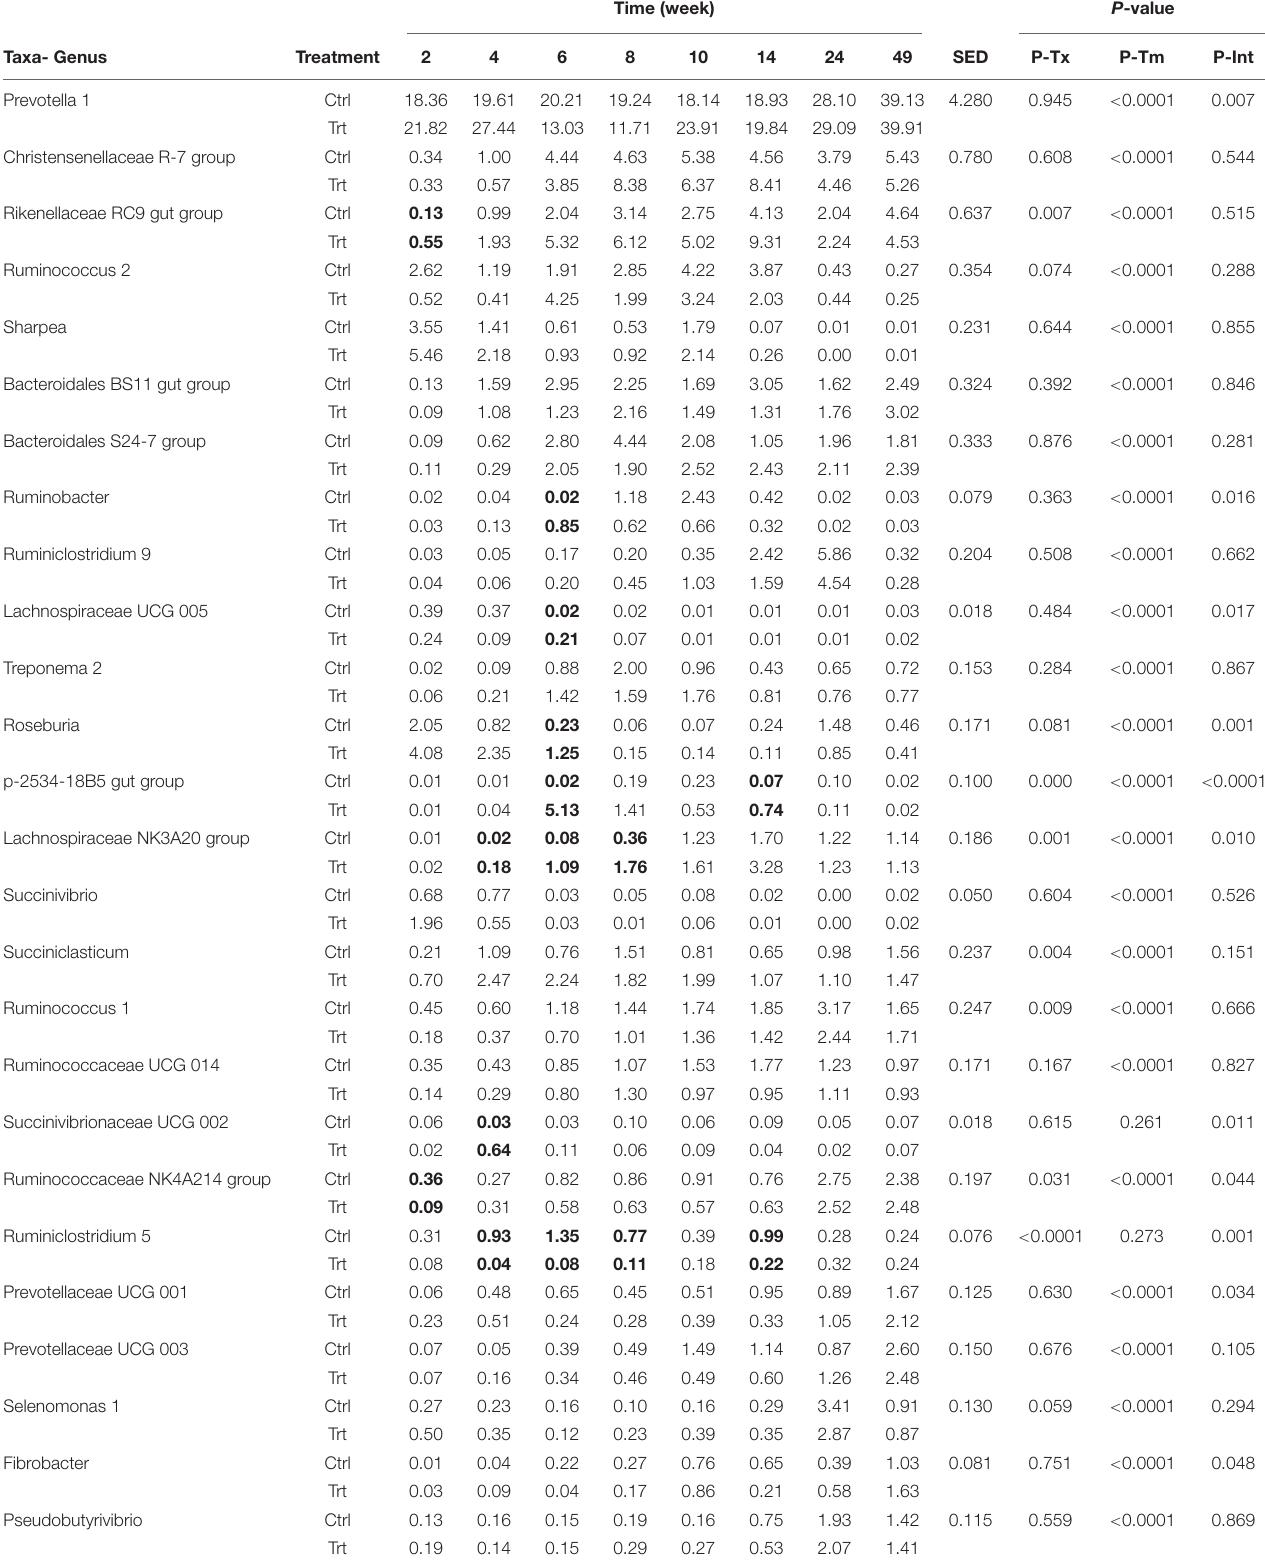
TABLE 6 | Effect of methane inhibitors 1 on the relative abundance of bacterial genus (%) 2 at different sampling times 3 . Time (week) P